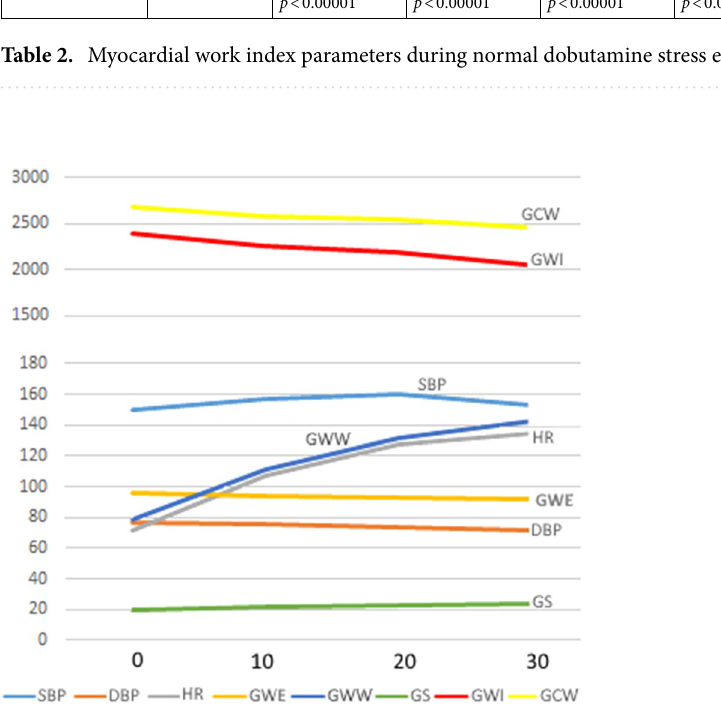
Figure 1. Changes in myocardial work index parameters during normal dobutamine stress echocardiography. SBP systolic blood pressure, DBP diastolic blood pressure, HR heart rate, GS global strain, GCW global constructive work, GWW global wasted work, GWE global work efficacy, GWI global work